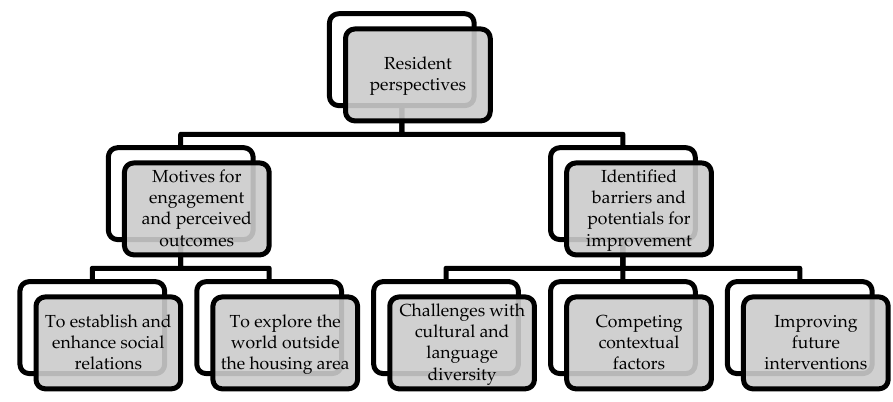
Figure 2. Structure of thematic network.